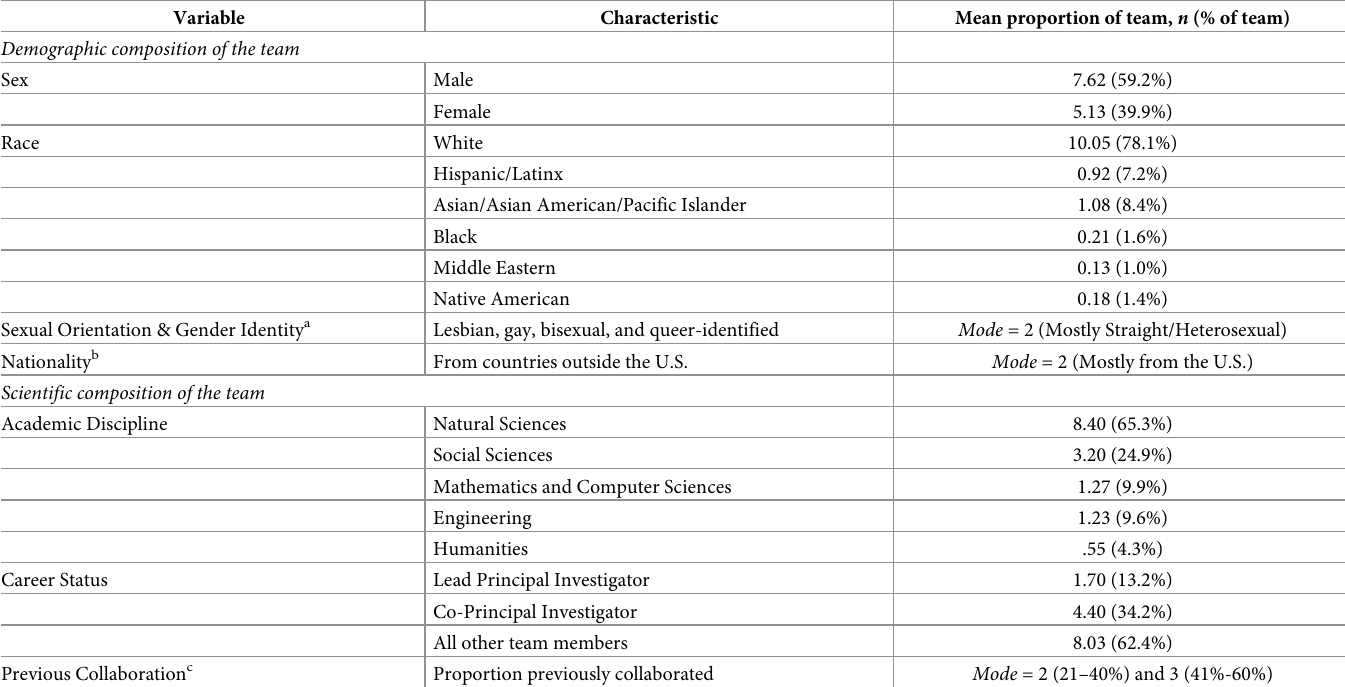
Table 2. Demographic and scientific composition of the teams of the survey respondents.